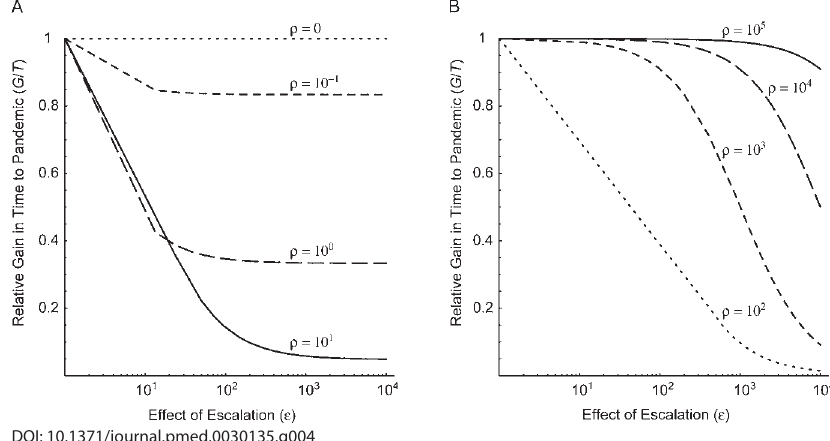
Figure 4. Relative Gain in Time to a Pandemic (G/T) as a Function of the Effect of Escalation on the Hazard of Introduction (ε = λ 1 /λ 0 ) , Assuming Infi nite Containment Attempts with 50% Success Probability Are Possible Each curve corresponds to a 10-fold increase in the magnitude of the escalation hazard relative to the initial hazard of introduction (ρ = λ E /λ 0 ) , ranging from 0.1 to 10 (A, short-dashed, long-dashed, and solid lines), and from 100 to 100,000 (B, dotted, short-dashed, long-dashed, and solid lines). When the relative magnitude of the escalation hazard is zero (A, dotted line), the relative gain in time to a pandemic is identical to the simple Poisson process in Figure